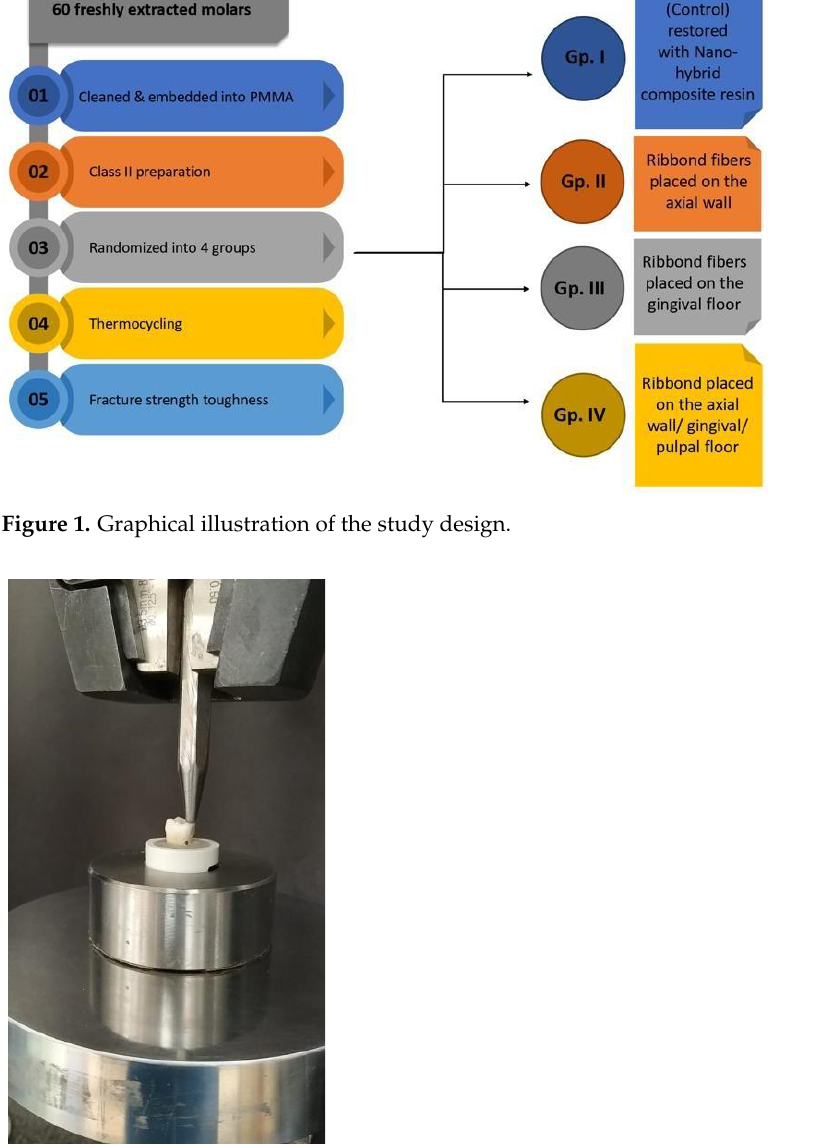
Figure 2. Fracture strength test by universal testing machine using a 3 mm diameter steel ball contacting the restoration at the isthmus area at a crosshead speed of 0.5 mm/min until fracture.